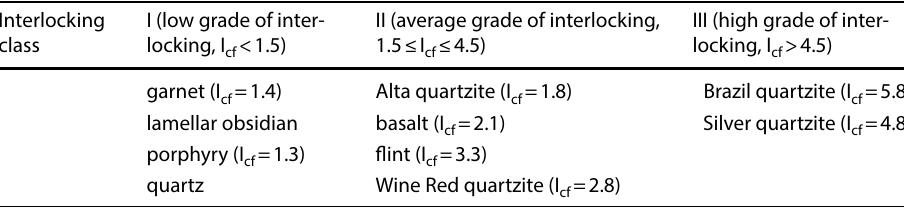
Interlocking class